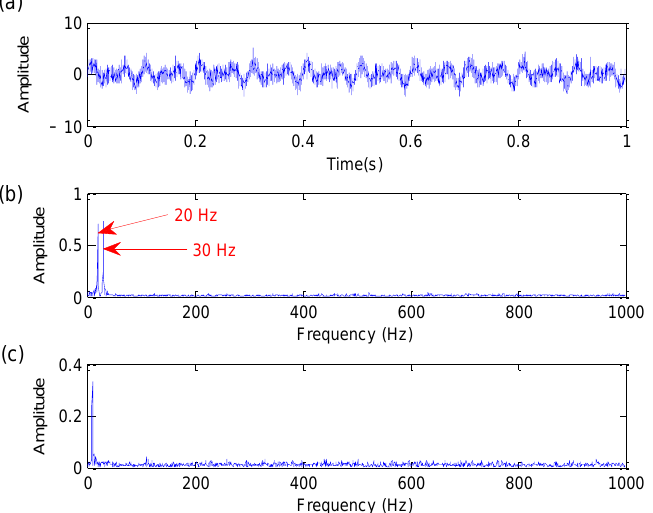
Figure 2. Bearing fault simulation signal: ( a ) Time domain waveform; ( b ) amplitude spectrum; ( c ) envelope spectrum.